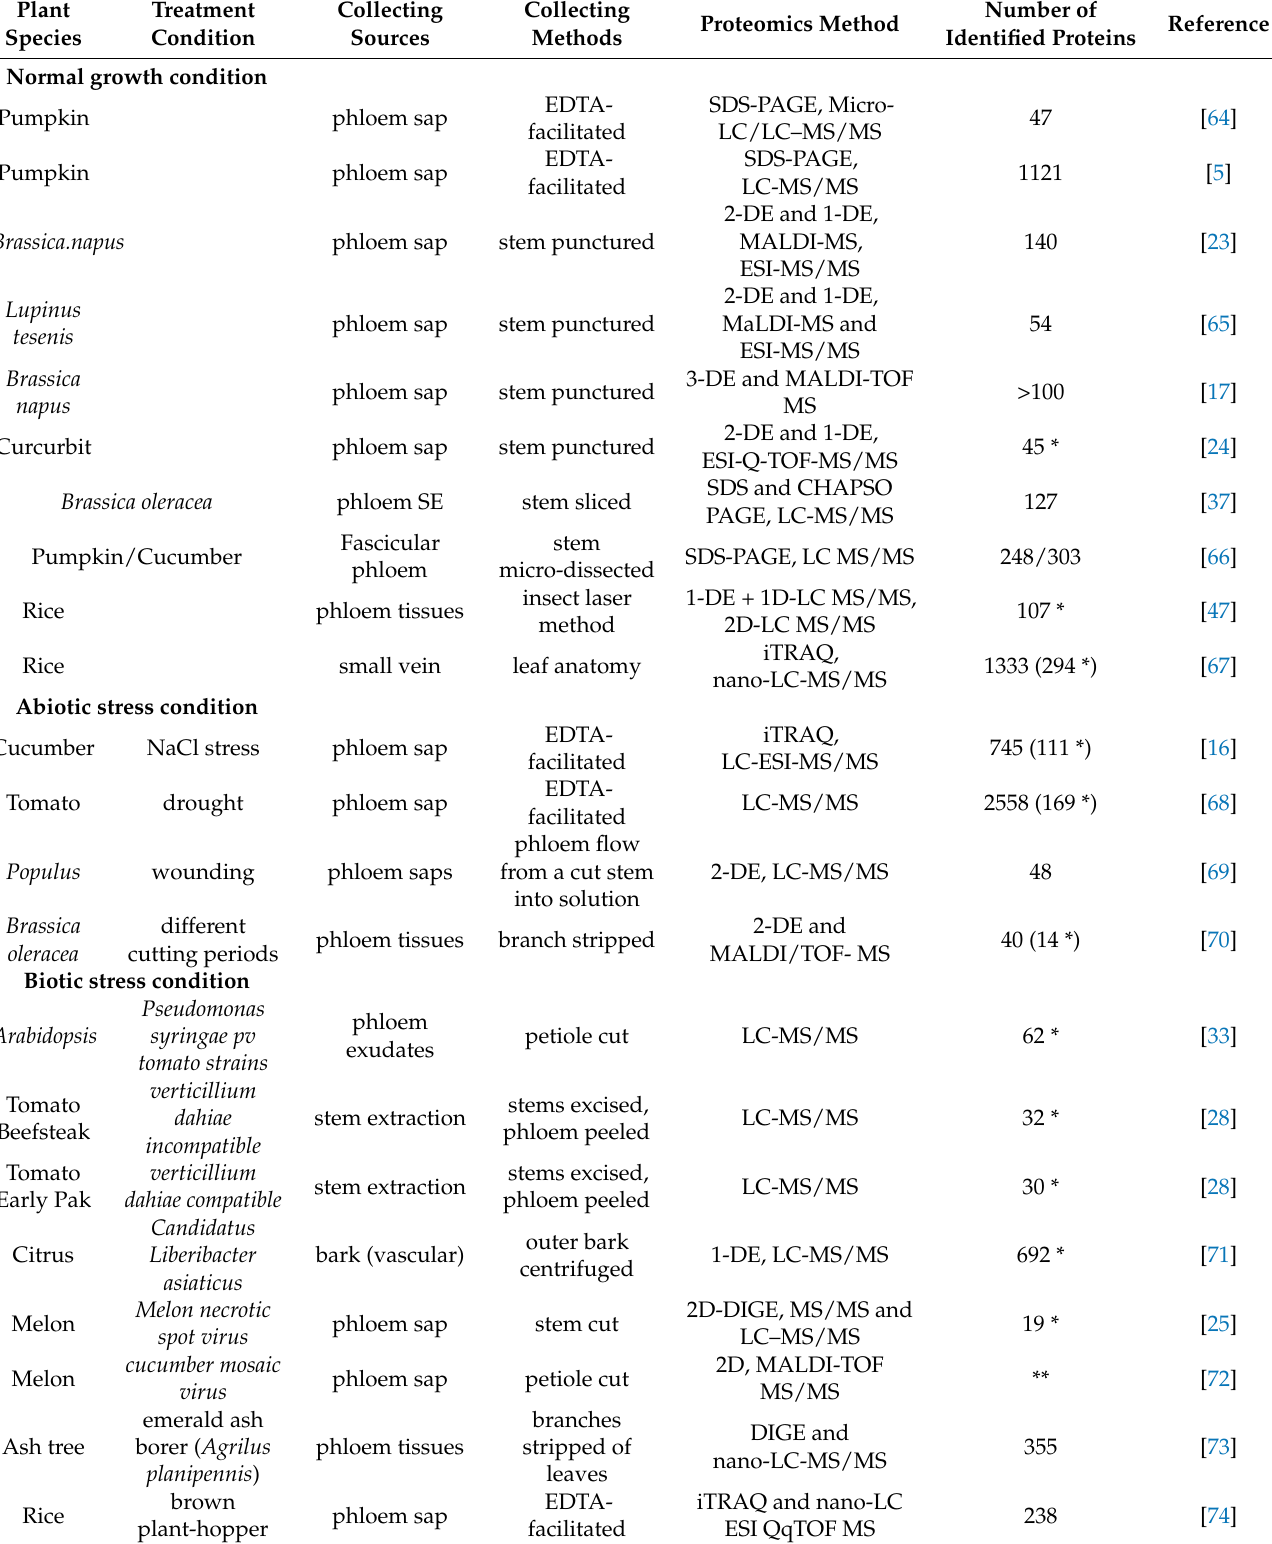
Table 2. Overview of the phloem